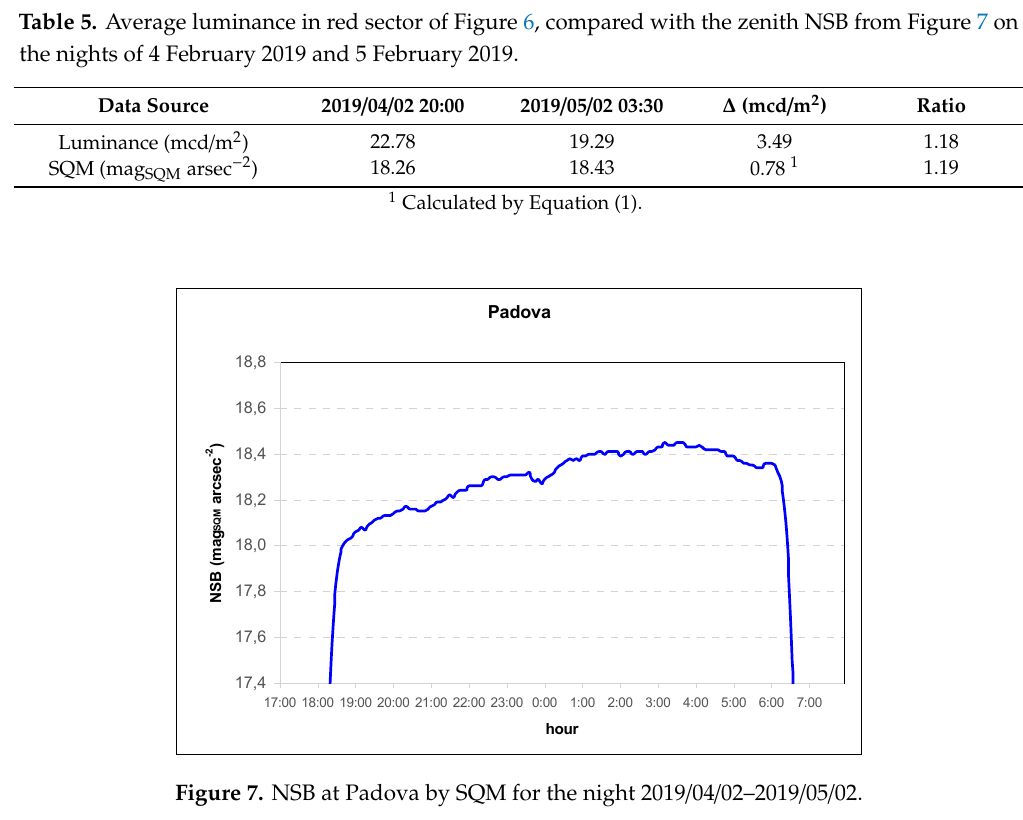
Figure 7. NSB at Padova by SQM for the night 2019/04/02–2019/05/02. Table 5. Average luminance in red sector of Figure 6, compared with the zenith NSB from Figure 7 on the nights of 4 February 2019 and 5 February 2019.